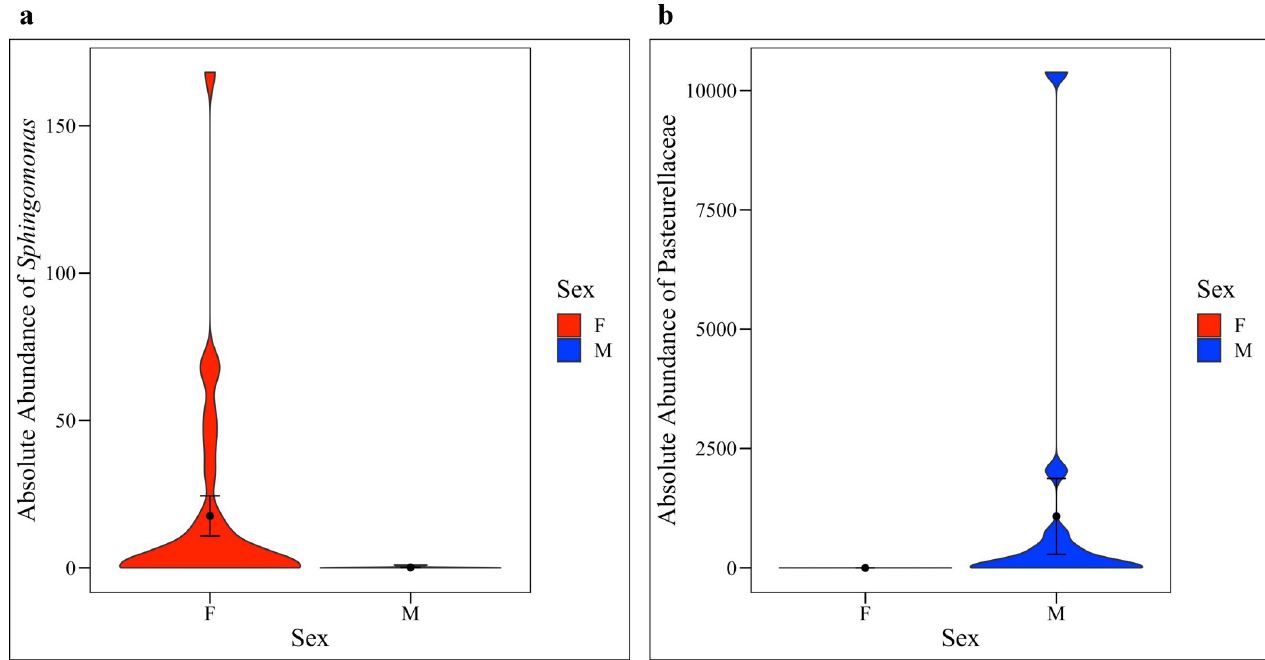
Fig 6. Differentially abundant taxa by sex. ( a ) Females had significantly greater absolute cell counts of Sphingomonas (Kruskal-Wallis, p = 0.0066) while ( b ) males had significantly greater absolute cell counts of Pasteurellaceae bacterium canine oral taxon 272 (Kruskal-Wallis, p = < 0.001). Only samples with > 300 reads and at least 2 qPCR replicates are included in this